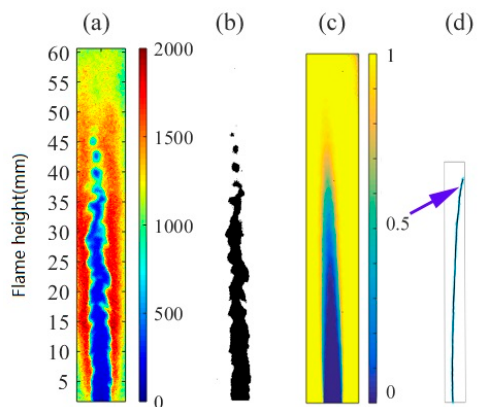
Figure 3. Data process and calculation of the turbulent flame speed: ( a ) flame instantaneous image of typical OH-PLIF; ( b ) flame instantaneous image of unburned and burned areas; ( c ) probability distribution images of unburned and burned areas; ( d ) contour lines of value 0.5 and corresponding fitting lines (extracted from Figure 2c).